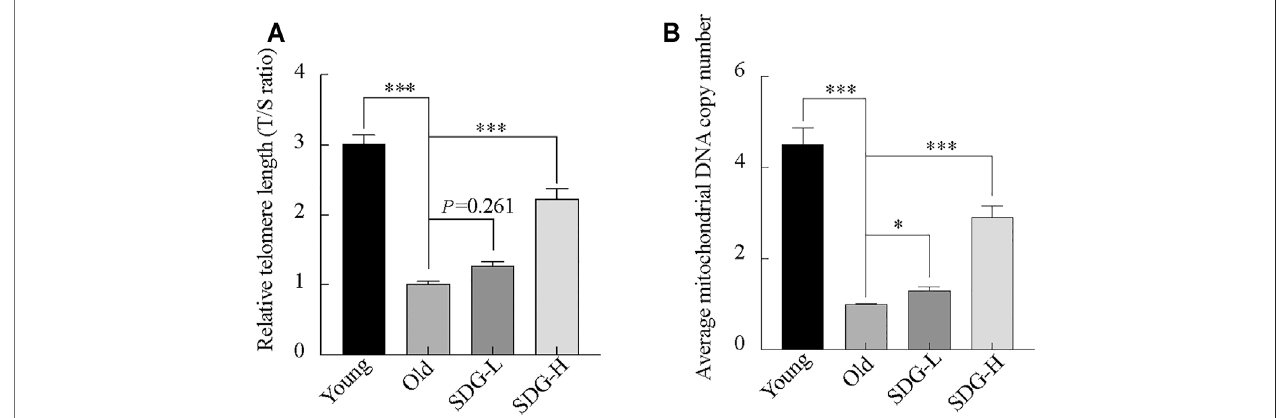
FIGURE 6 | Telomere length, mitochondrial DNA copy number in the ovaries of mice after intragastric administration of SDG. (A) Relative telomere length was estimated as the T/S ratio by quantitative real-time PCR analysis. (B) Average mitochondrial DNA copy number was determined by the ratio of the levels of the single- copy mitochondrial gene to the single-copy nuclear gene by real-time PCR analysis. The data are expressed as mean ± SEM. * P < 0.05, ** P < 0.01, *** P < 0.001. The P value is labeled if P >